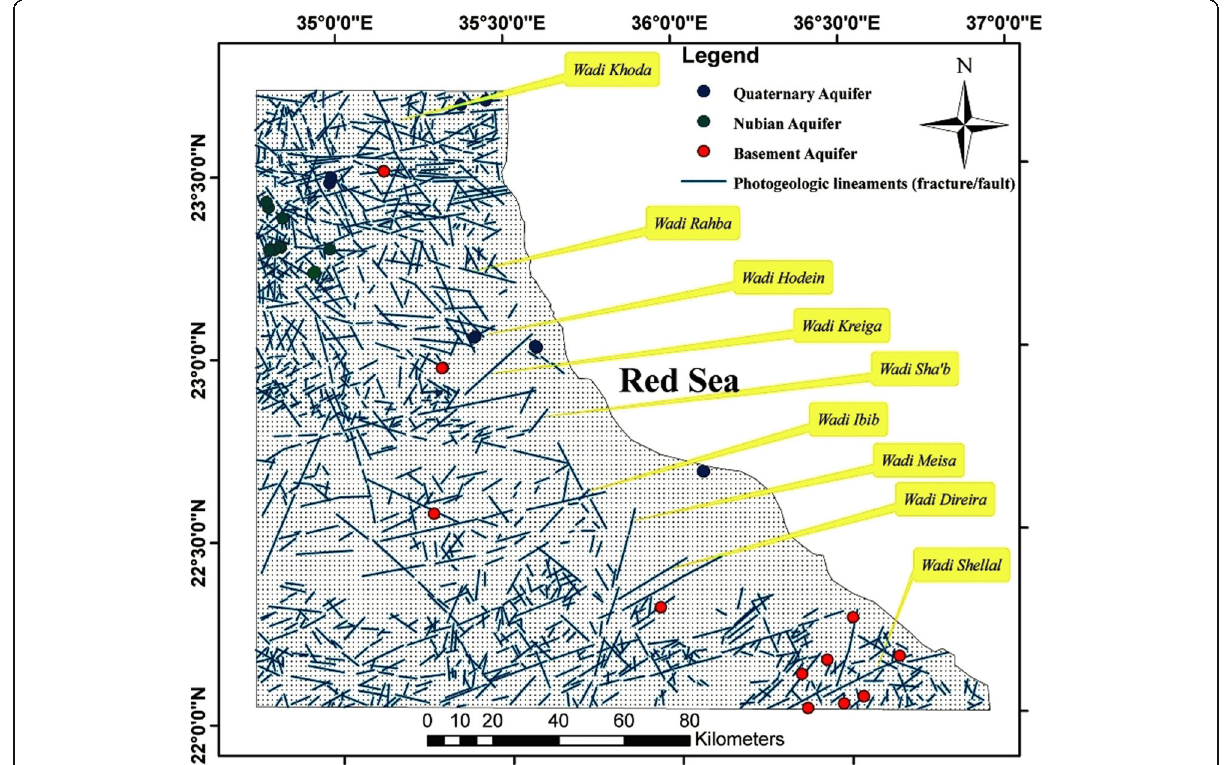
Fig. 7 Structural lineaments layer is overlaid by existed groundwater